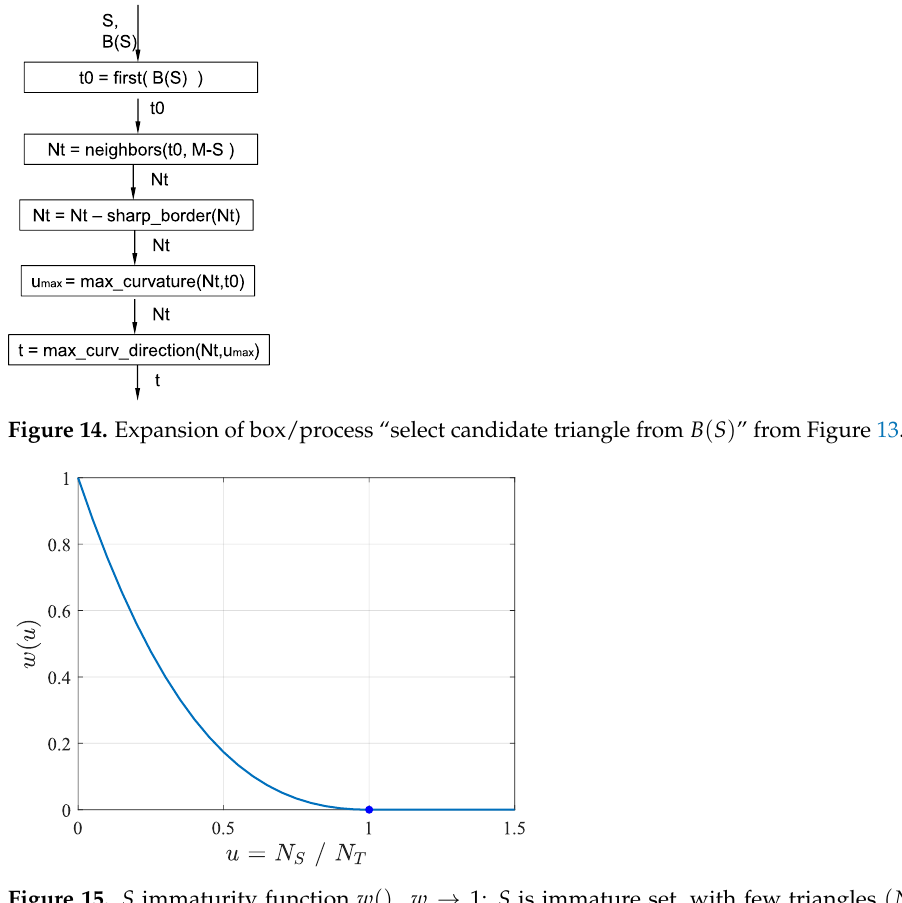
Figure 15. S immaturity function w () . w → 1: S is immature set, with few triangles ( N S → 0 ) . w → 0: S is mature set, with many triangles ( N S > N T ). N T = threshold in number of triangles to consider g () as stable analytic